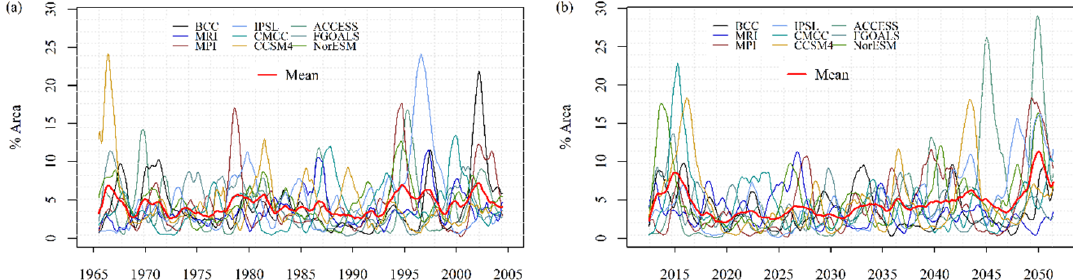
Figure 3. Proportion of conterminous USA land area under severe drought for ( a ) historical and ( b ) projected periods.